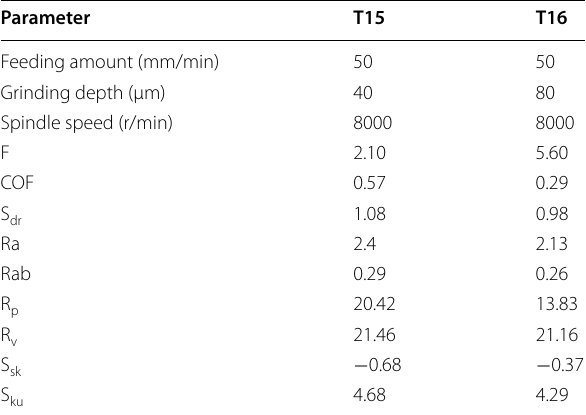
Table 5 Experimental parameters comparison of T15 and